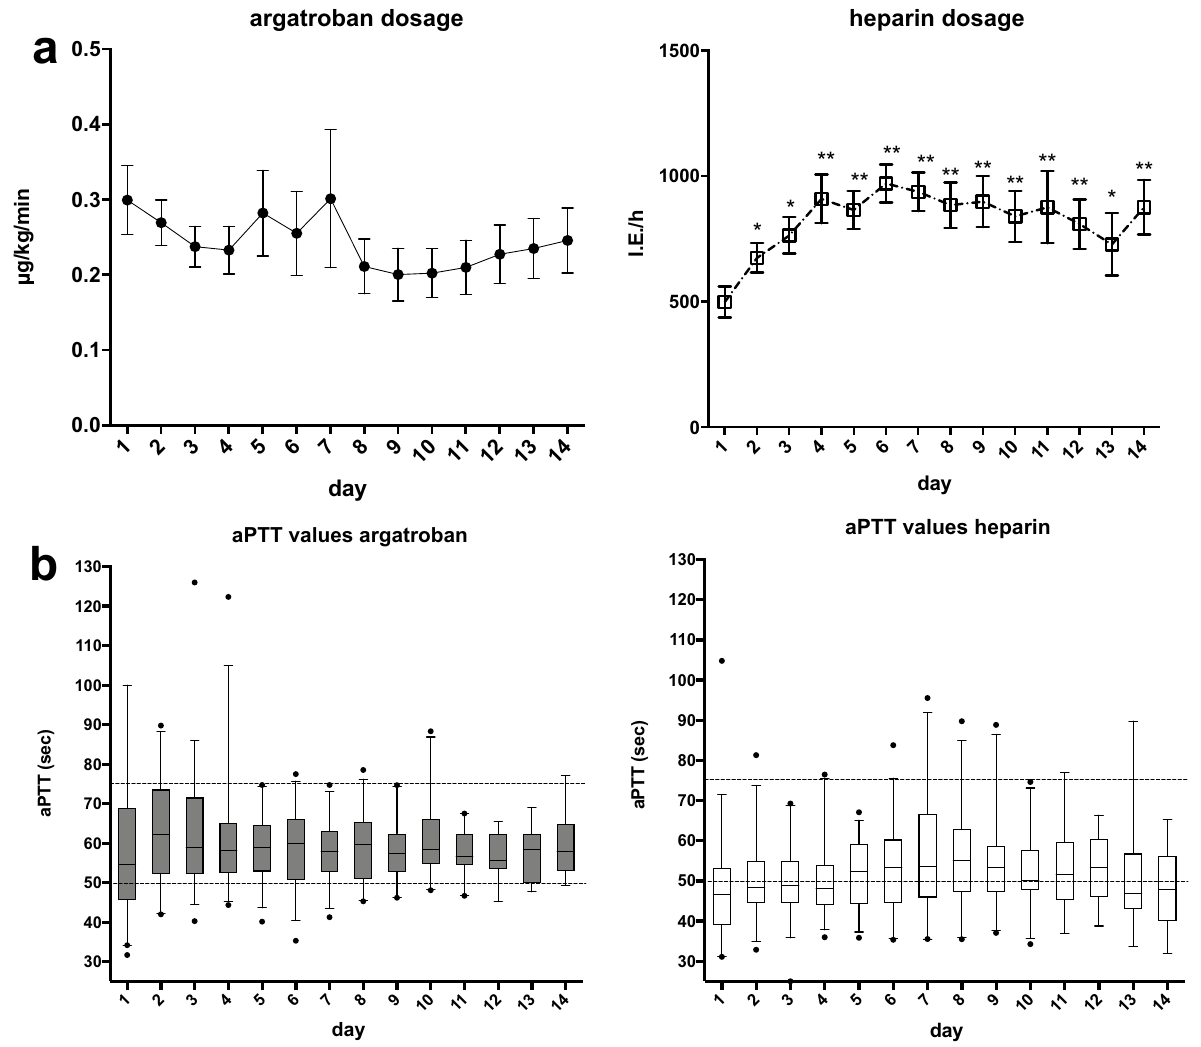
Fig. 2 Comparisons of a dosage; b aPPT values; in ARDS patients undergoing extracorporeal lung support with either argatroban or heparin as anticoagulant in the first consecutive 14 days of therapy left : argatroban; right : heparin. Data are presented as mean (SEM) and were analyzed with a Mann–Whitney U test for nonparametric samples. * p < 0.05; ** p < 0.01 compared to day 1. APTT activated thrombo‑ plastin time; µg/kg/min microgram per kilogram bodyweight per minute; IU/h international units per hour; s seconds; extracorporeal lung support : pECLA pumpless extracorporeal lung assist or ECMO extracorporeal membrane